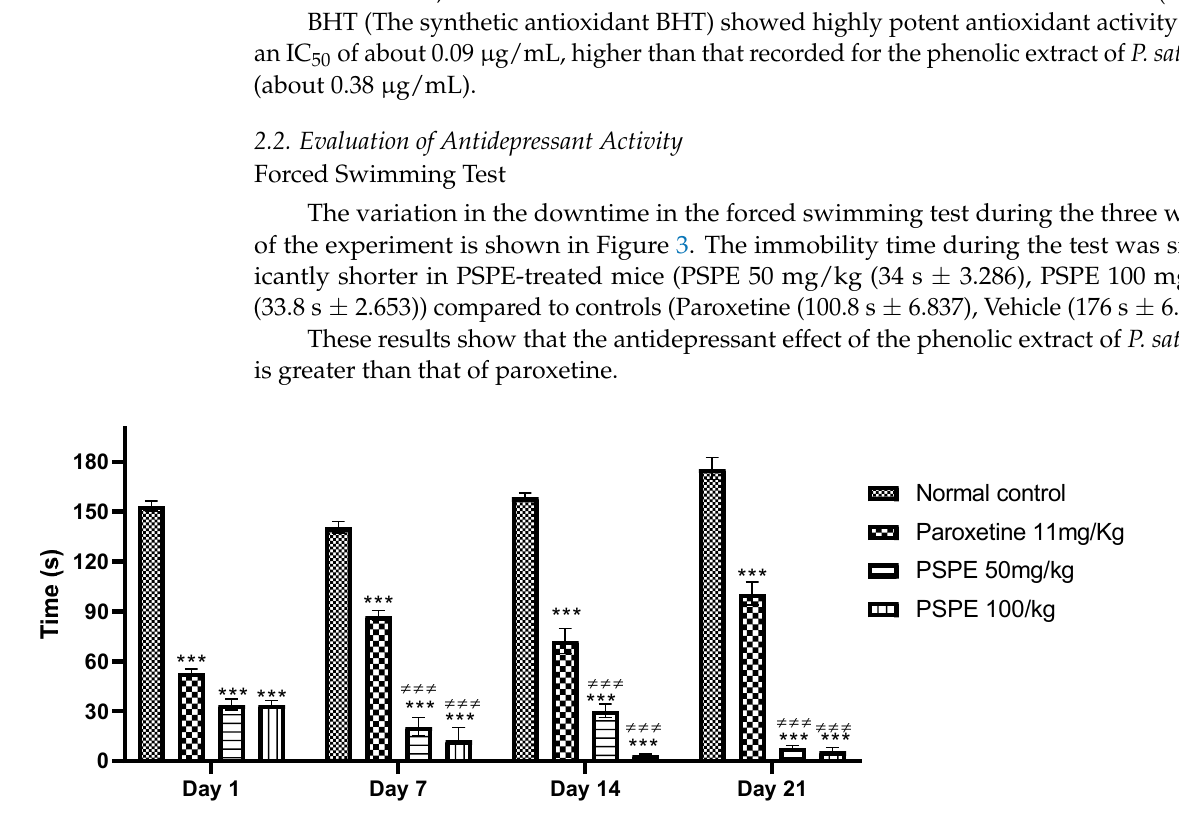
Figure 3. Variation in immobility time during three weeks of treatment in control and treated mice (*** p ≤ 0.001 in com- parison to negative controls, ≠≠≠ p ≤ 0.001 in comparison to positive controls). PSPE: Polyphenolic fraction of P. sativum.